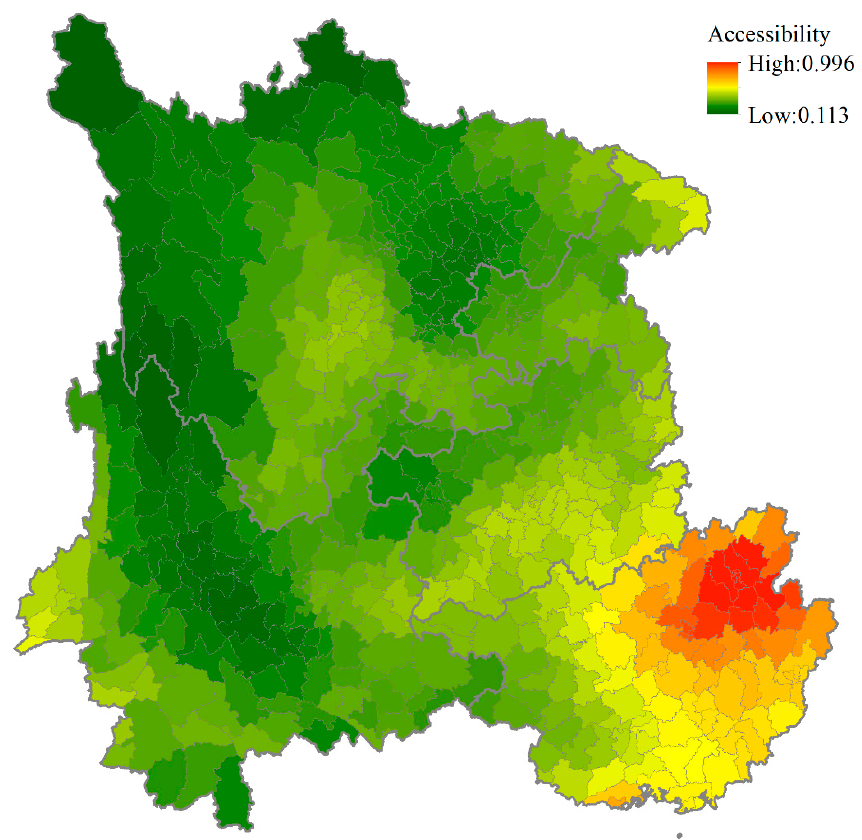
Figure 4. The spatial pattern of water resource accessibility in Southwest China at the county scale.